Question: According to this chart, does the measure grow or shrink?
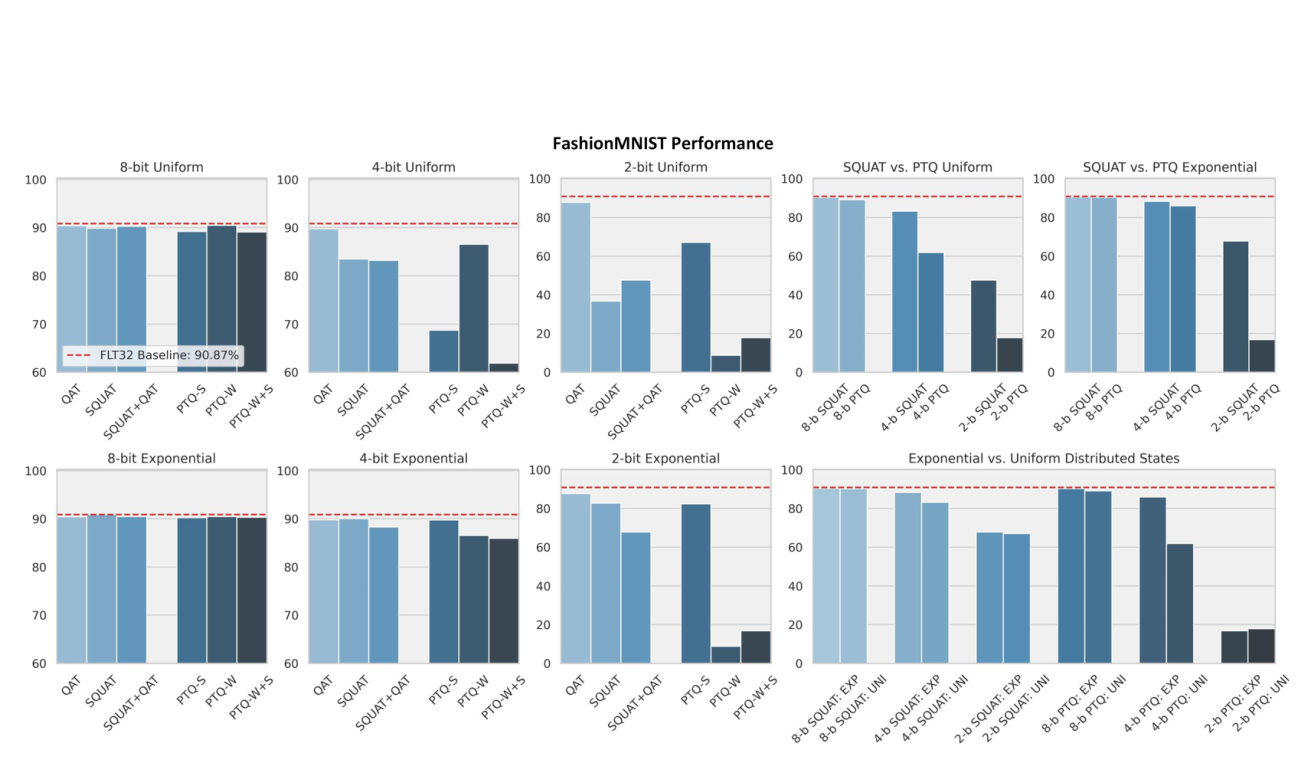
Answer: increasing